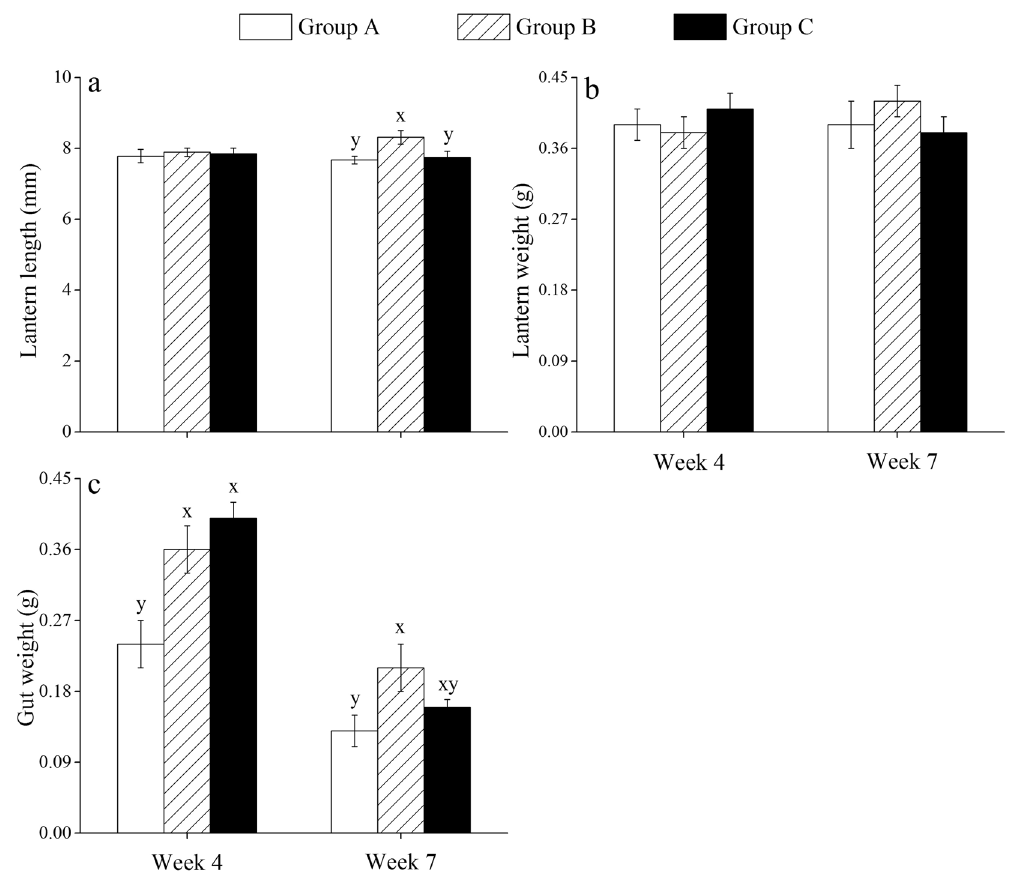
Figure 4. Lantern length ( a ), wet lantern weight ( b ) and wet gut weight ( c ) of Strongylocentrotus intermedius of the experimental groups in week 4 and week 7 (mean ± SD, N = 8). Letters above the bars represent significance in each week ( P <